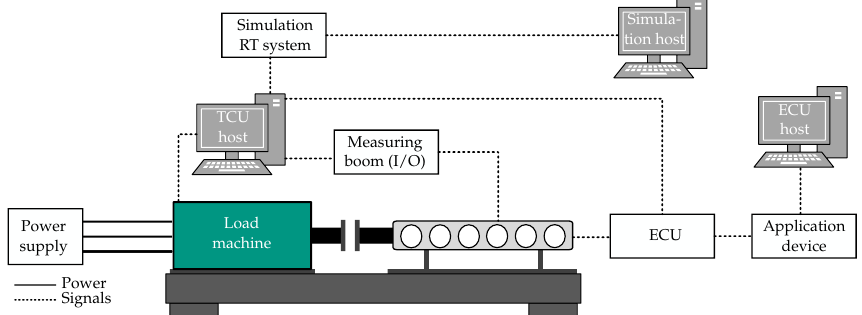
Figure 3. Schematic setup of the ICE test bench.